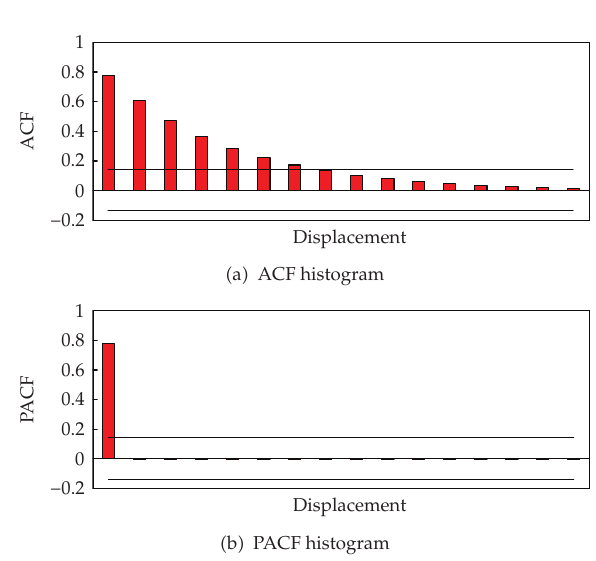
Figure 6: Histograms of spatial ACF and PACF based on the exponential